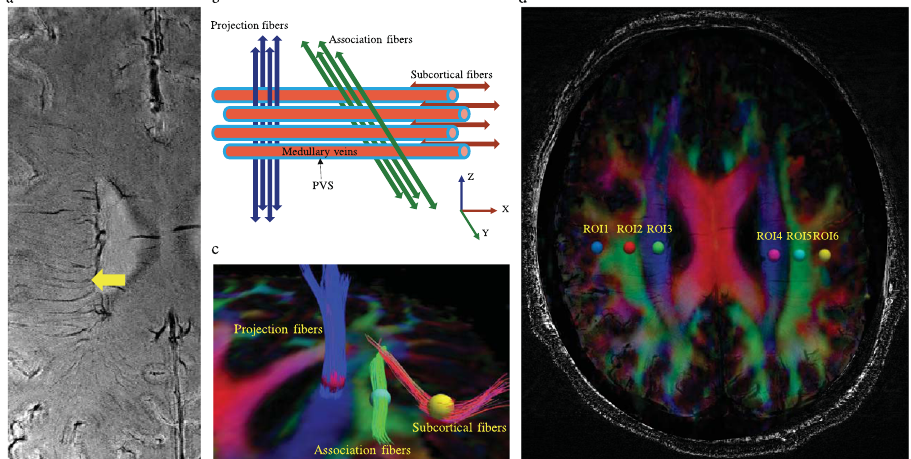
Fig. 3 Illustration of the diffusion tensor image analysis along the perivascular space (DTI-ALPS) method. a Axial susceptibility-weighted imaging (SWI) map at the level of the lateral ventricle body showing the medullary veins that run perpendicular to the ventricular wall (yellow arrow). b Schematic drawing of the spatial relationships between perivascular space and the white matter fi bers. c Fiber tracking of projection, association, and subcortical fi bers. d Fusion of SWI and color-coded fractional anisotropy (FA) maps. Six regions of interests (ROIs) are located in the areas of projection fi bers, association fi bers, and subcortical fi bers